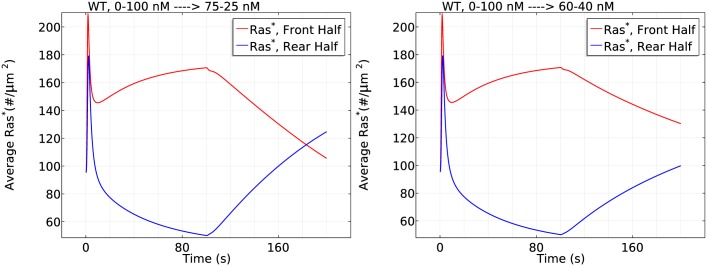
The response when the reversed gradient is shallower.Left: 75–25 nM after 100 seconds. Right: 60–40 nM after 100 seconds.